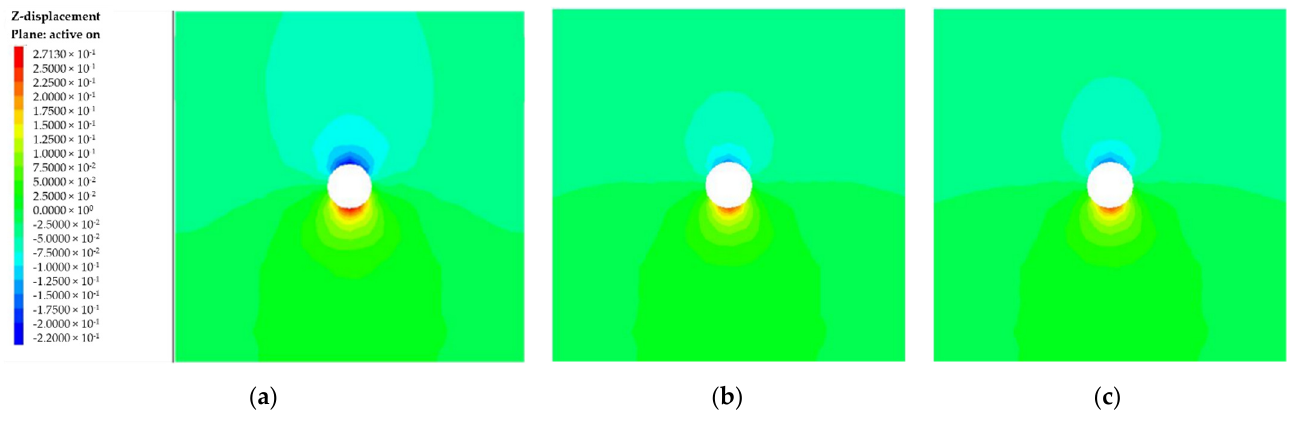
Figure 9. Vertical displacement distributions of the surrounding rock of the support face: ( a ) unsup- ported, ( b ) radial support, and ( c ) non − radial support.